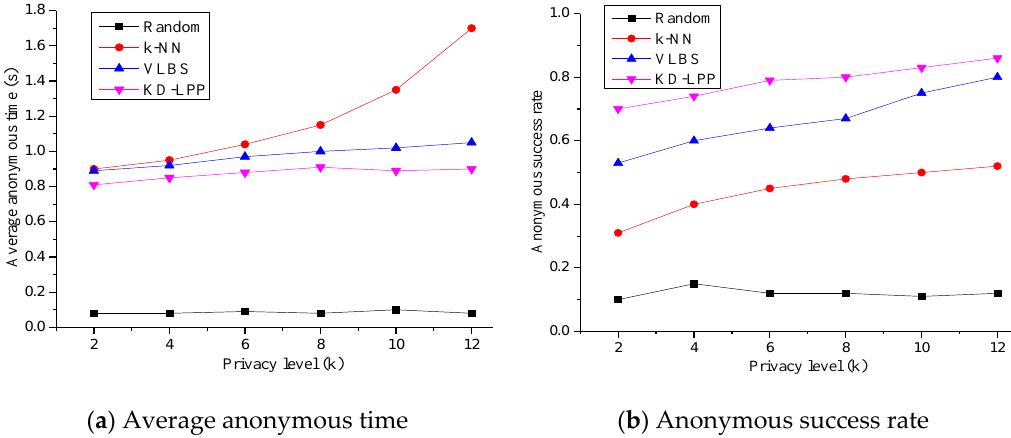
Figure 7. Effect of location set entropy and location distance entropy.